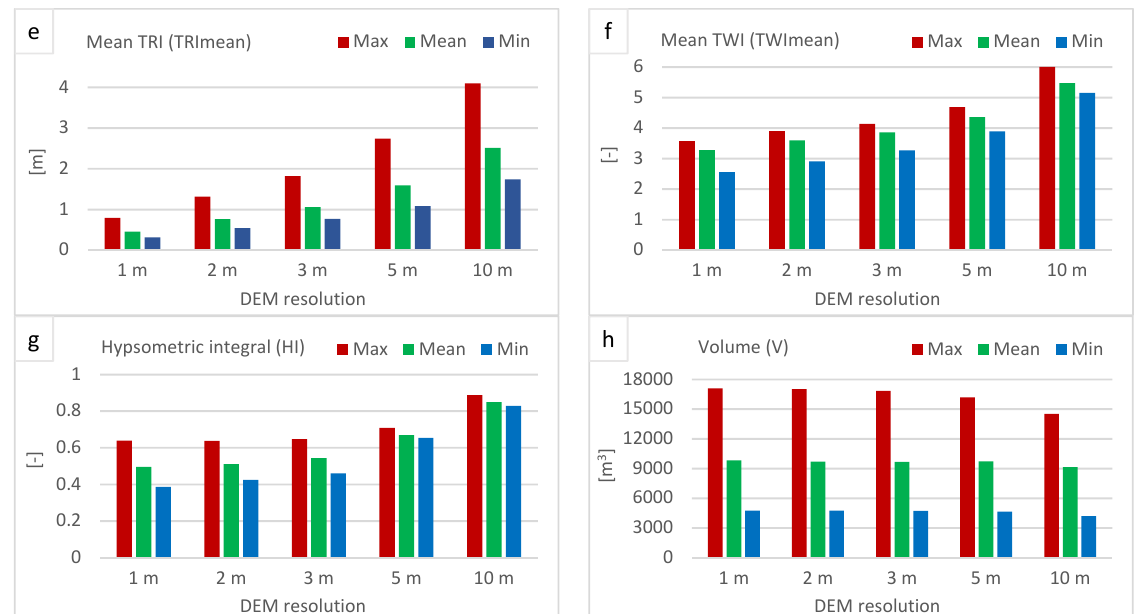
Figure 10. Variation in maximum, mean, and minimum of the selected hypsometric parameters for 1 m, 2 m, 3 m, 5 m, 10 m LiDAR DEM (based on the large size valleys): ( a ) Zmean parameter; ( b ) Zrange parameter; ( c ) Smean parameter; ( d ) Amean parameter; ( e ) TRImean parameter; ( f ) TWImean parameter; ( g ) HI parameter; ( h ) V parameter.